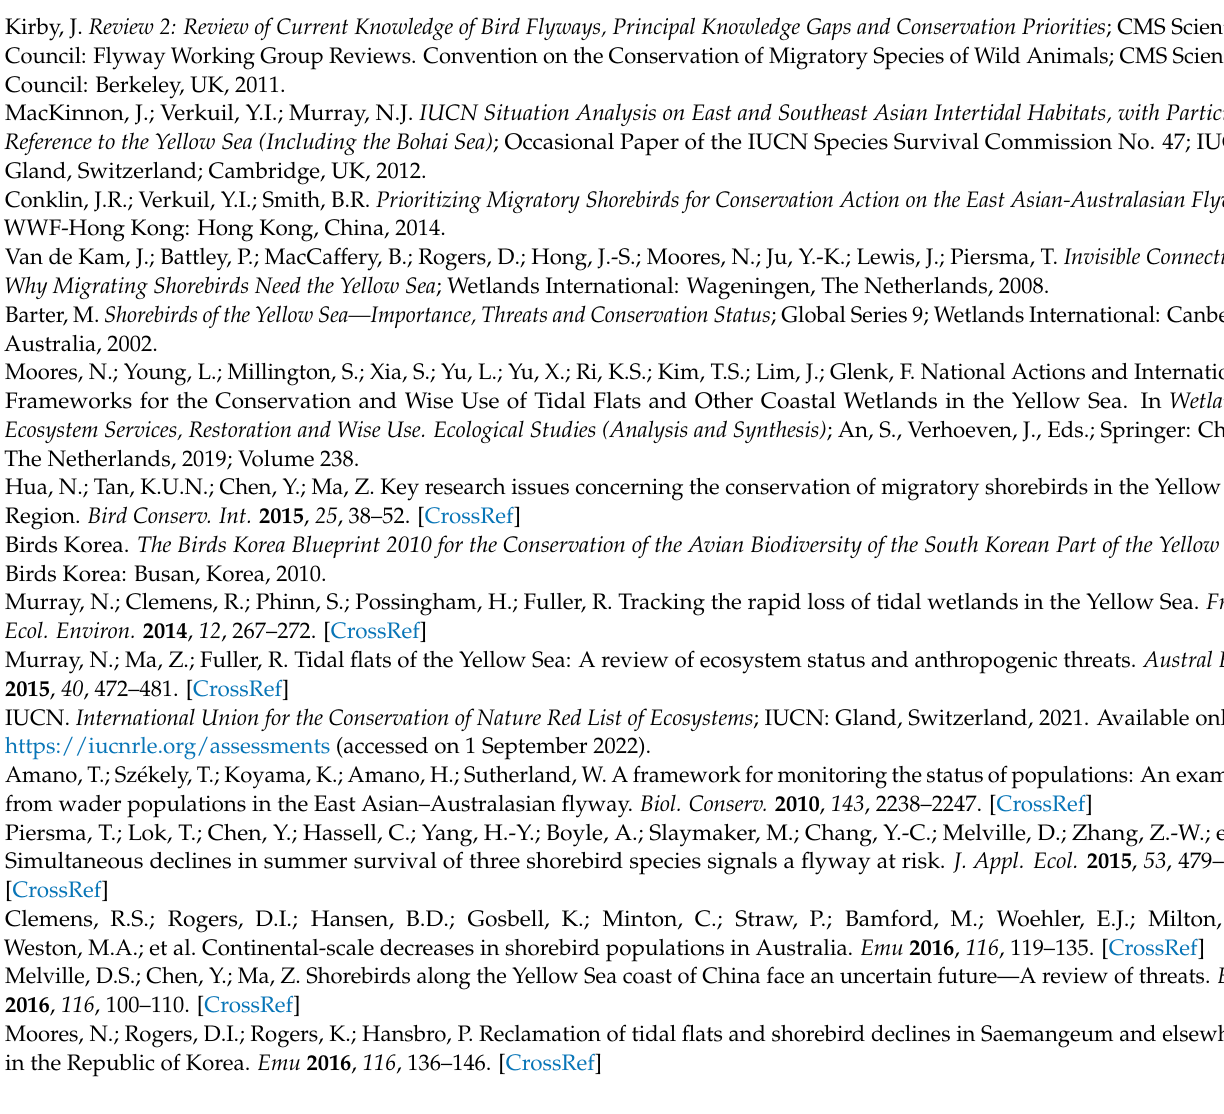
Table A2. Cont. Highest Day Count